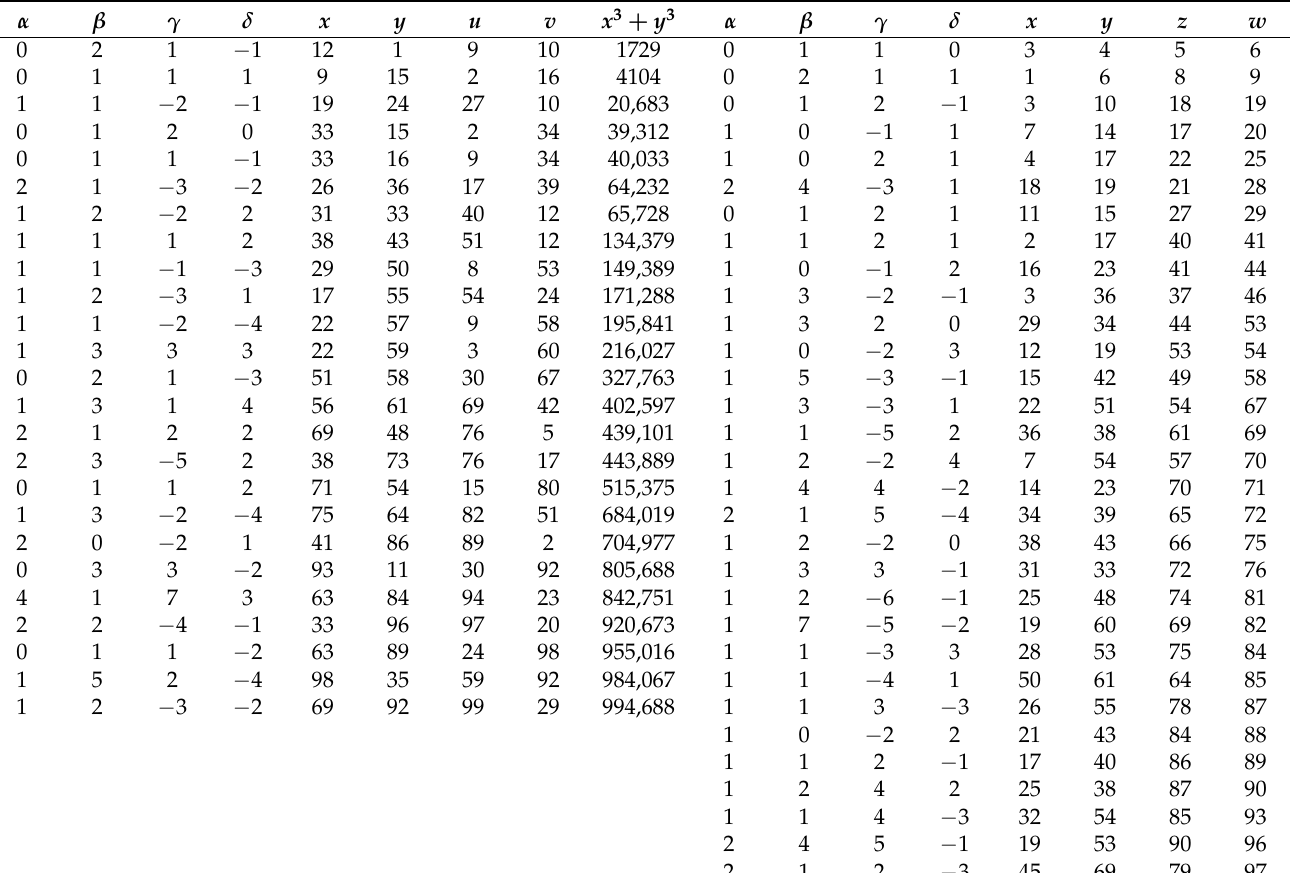
Table 1. Solutions to (2) (left-hand table) and (3) (right-hand